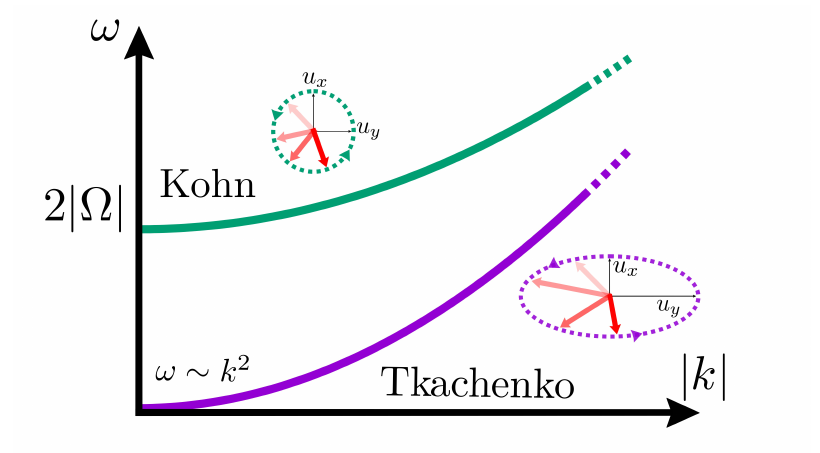
Figure 2: Sketch of dispersions and polarizations of Tkachenko and Kohn